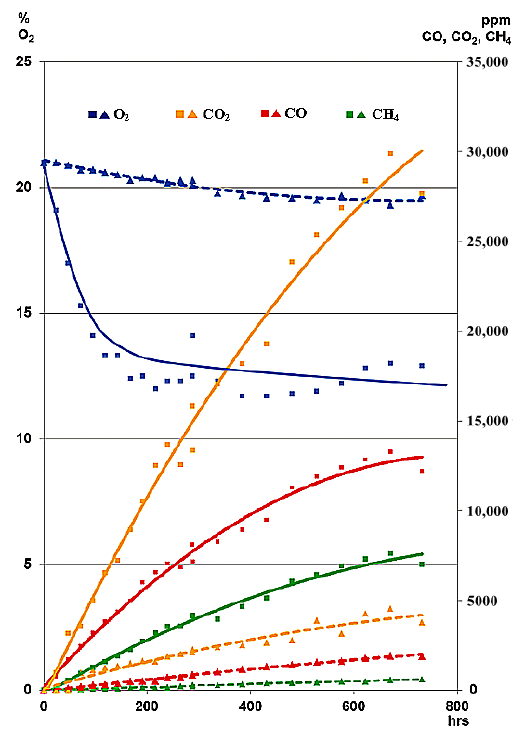
Figure 8. Concentration measured during off-gassing experiment. scCO 2 -extracted (dotted line) and non-extracted pellets (solid line, reference); 30 days storage in 19 L test cylinder at 23 °C. Adapted with permission from Ref. [94]. 2016, Royal Society of Chemistry.